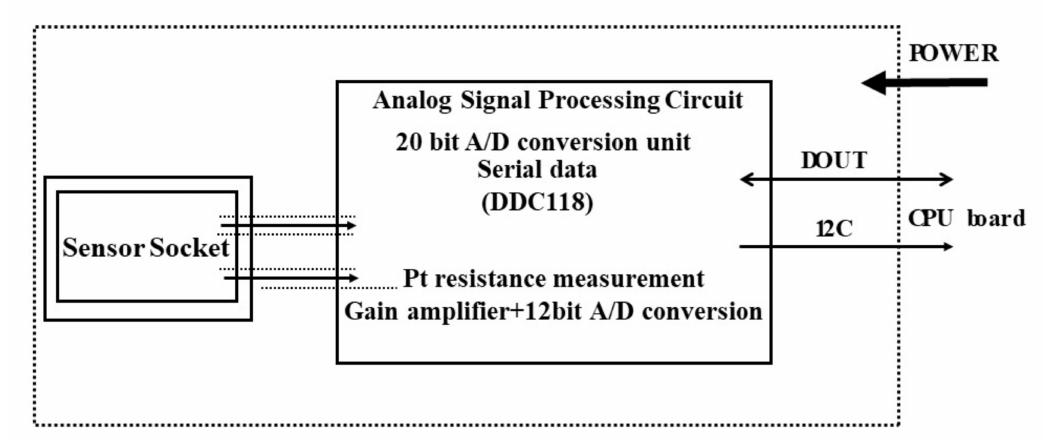
Figure 3. Schematic diagram showing the measurement of the sensor